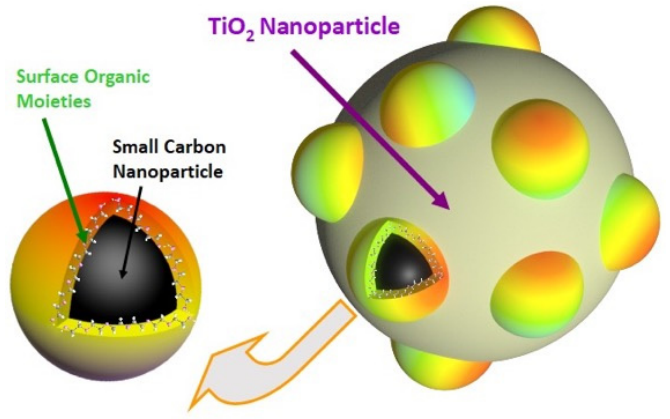
Figure 1. Cartoon illustration on C/TiO 2 hybrid dots ( right ), with the entities on the TiO 2 nanoparticle surface each being a nanoscale carbon domain with organic moieties, thus equivalent to the classically defined CDots (left) as small carbon nanoparticles with the surface passivation by organic functionalization.